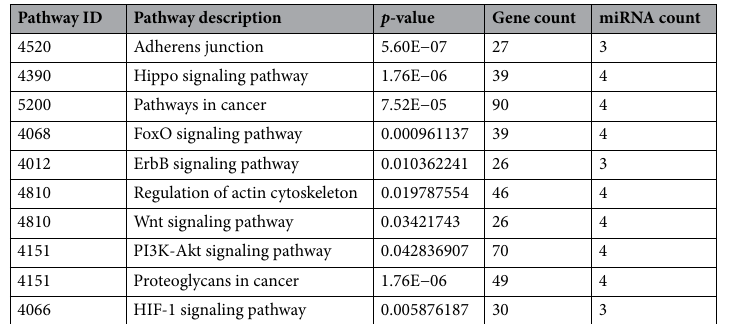
Table 2. KEGG pathways affected by epigenetically regulated